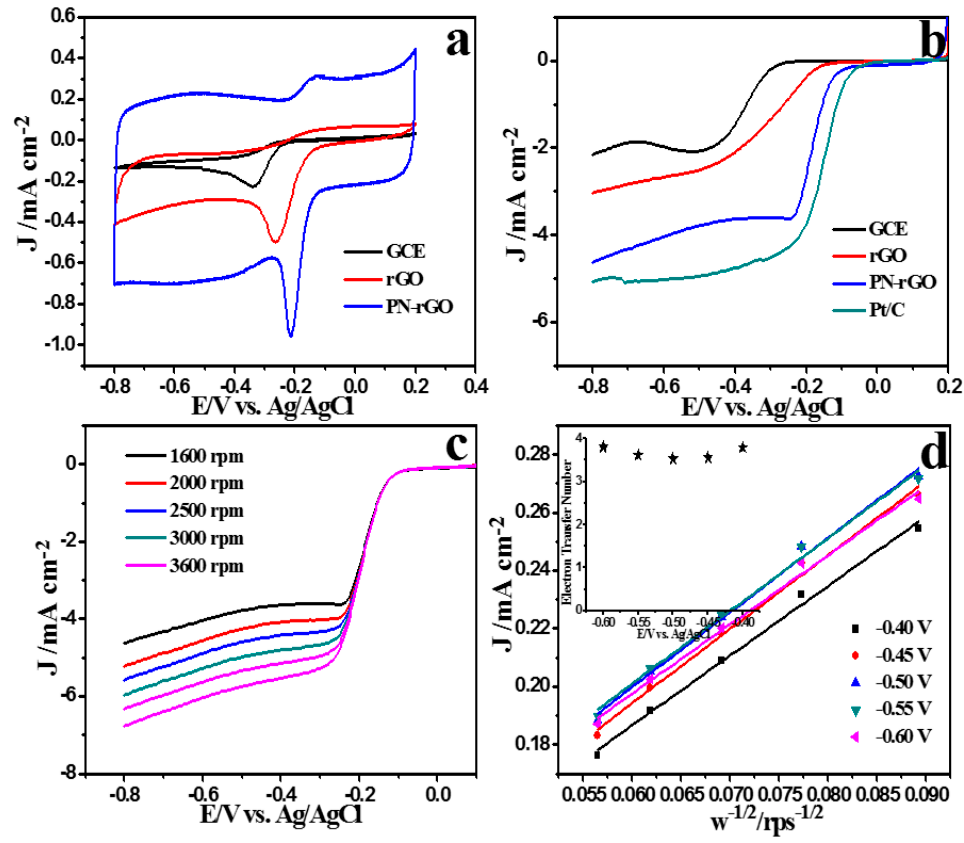
Figure 5. Cyclic voltammetry (CV) curves ( a ) and linear sweep voltammetry (LSV) curves at 1600 rpm ( b ) for different samples, LSV curves at different rotation rates ( c ) and the corresponding K-L plots ( d ) of